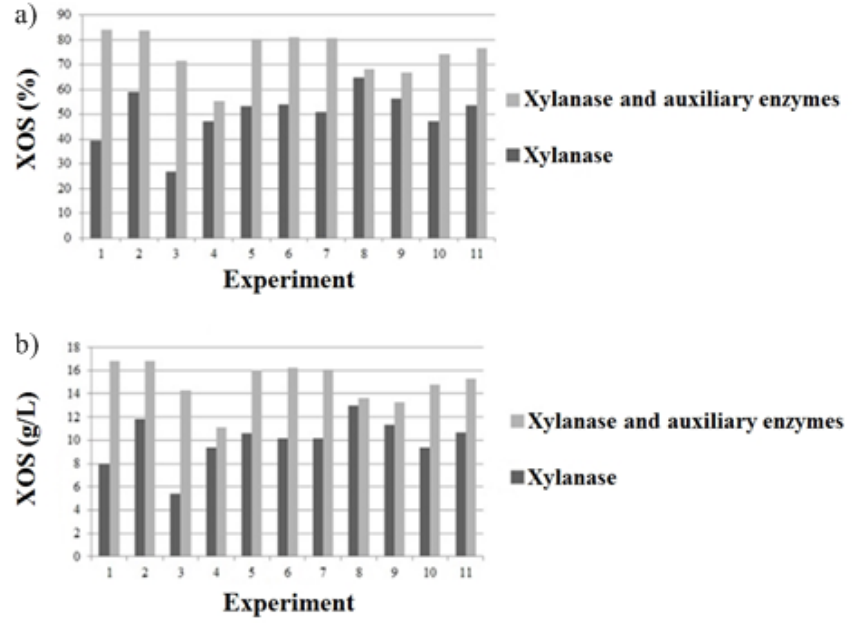
Figure 4. Xylooligosaccharides production by xylanase and auxiliary enzymes approach (IU/g) and only xylanase approach (IU/g). ( a ) Xylooligosaccharides yield (%) and ( b ) xylooligossaccharides concentration (g/L). The x -axis represents the number of experiments referred to in Table 2 compared to the absence of auxiliary enzymes.